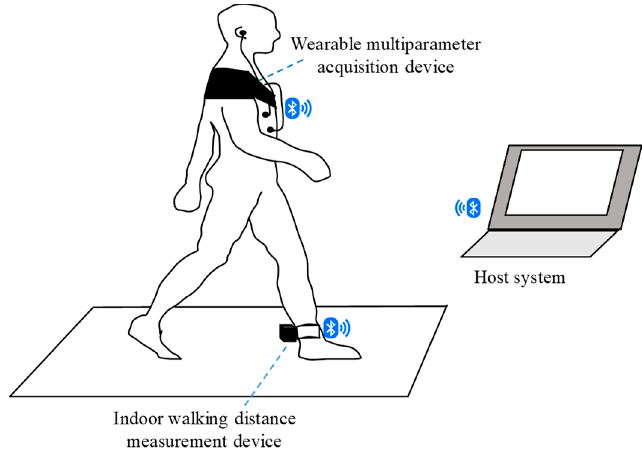
Figure 1. Basic scheme of the wearable cardiopulmonary function evaluation system.